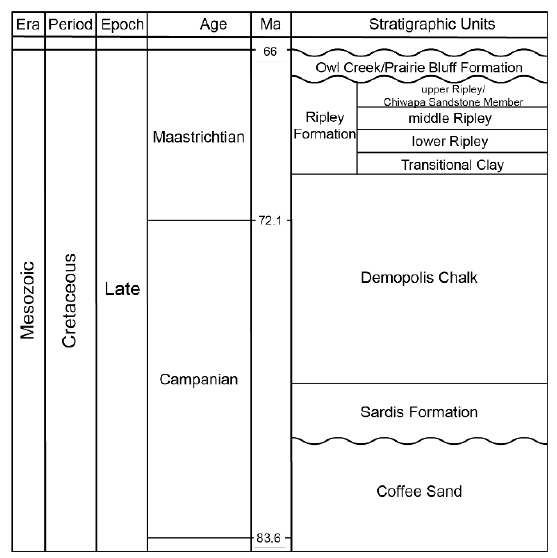
Figure 2. Generalized stratigraphic column of the Late Cretaceous units of northeastern Mississippi.